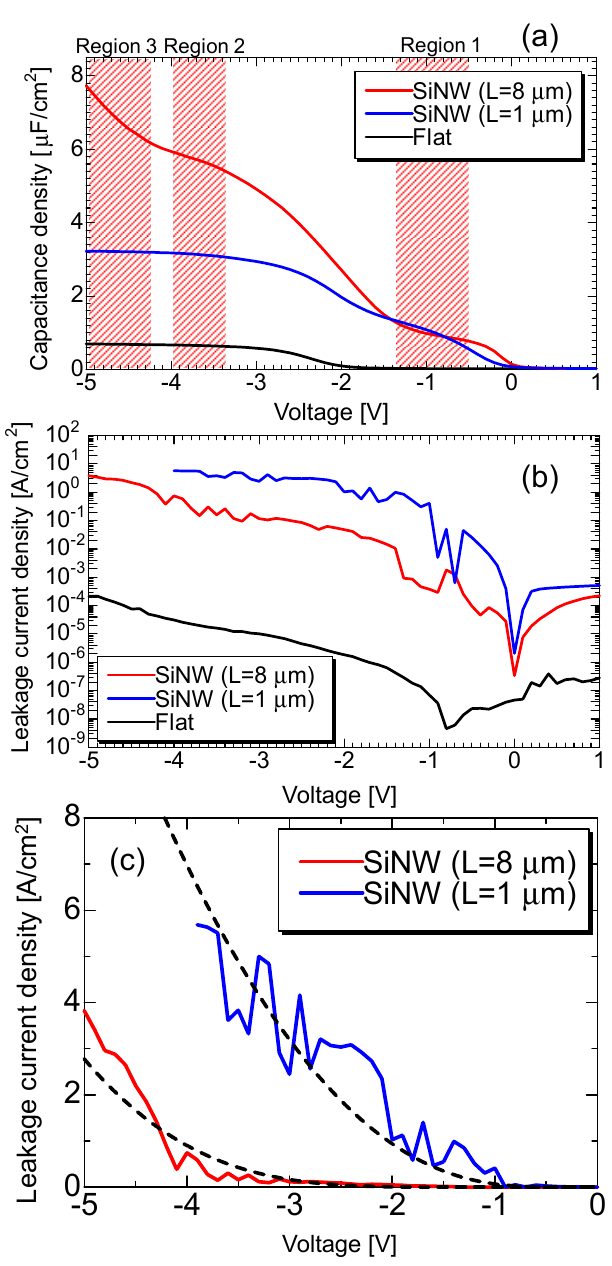
Figure 4. ( a ) C - V characteristics, ( b ) J - V characteristics of SiNW MOS capacitors (blue and red solid line) and flat MOS capacitors (black solid line). The vertical axis shows the absolute value of leakage current density. ( c ) J - V characteristics of SiNW MOS capacitors fitted by the Fowler–Nordheim tunneling equation.